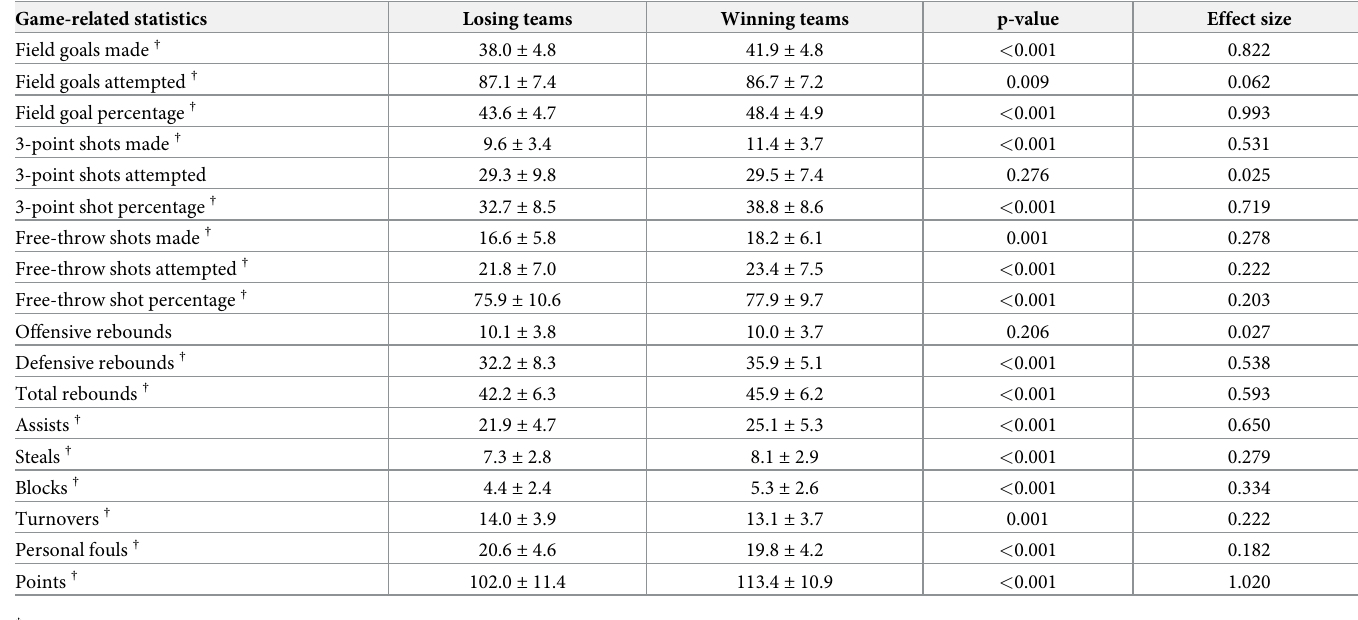
Table 2. Descriptive data ( � x � ± SD) for game-related statistical parameters between winning and losing teams during the regular season competitive